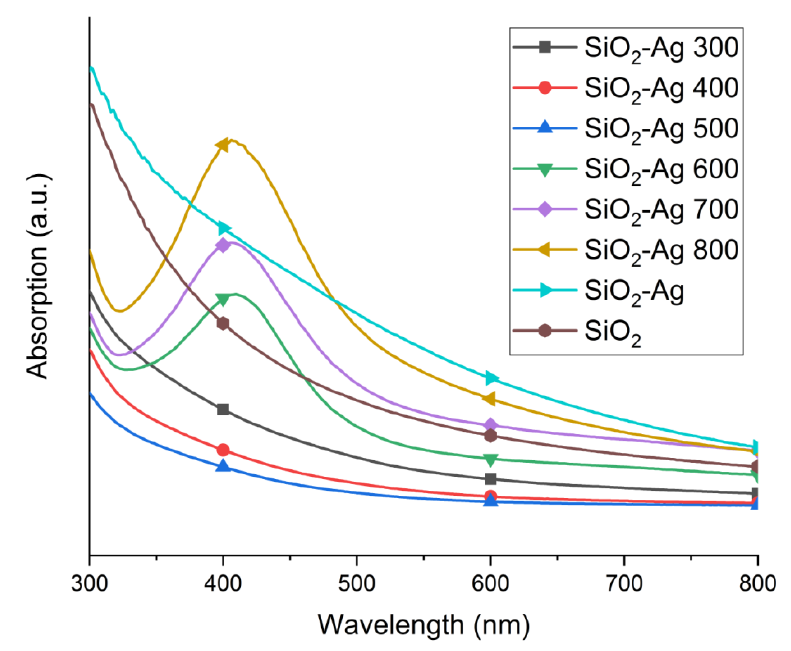
Figure 3. UV-vis spectra of SiO 2 and SiO 2 -Ag powders, showing the silver SPR peak around 410